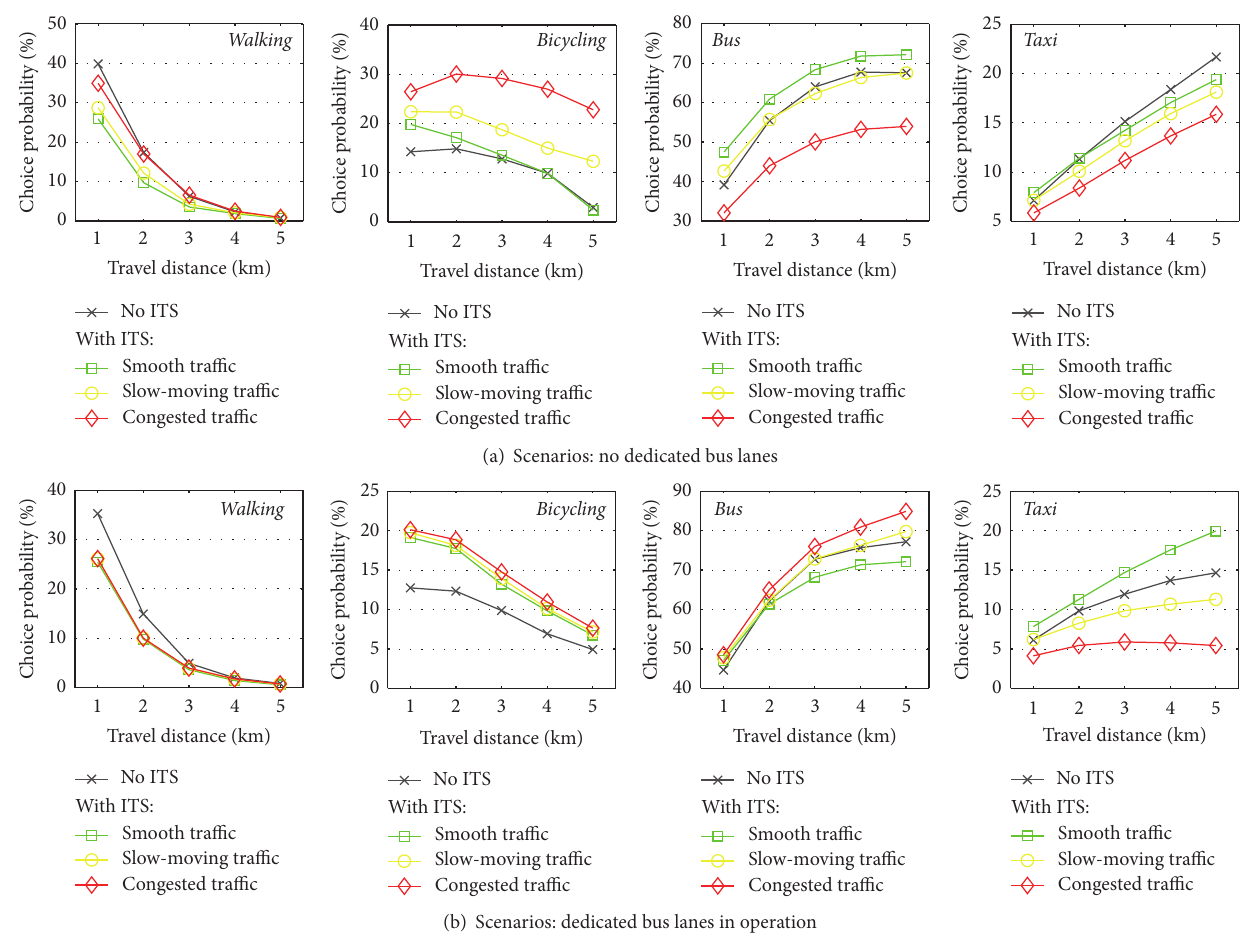
Figure 3: Predicted choice probabilities of FIT by